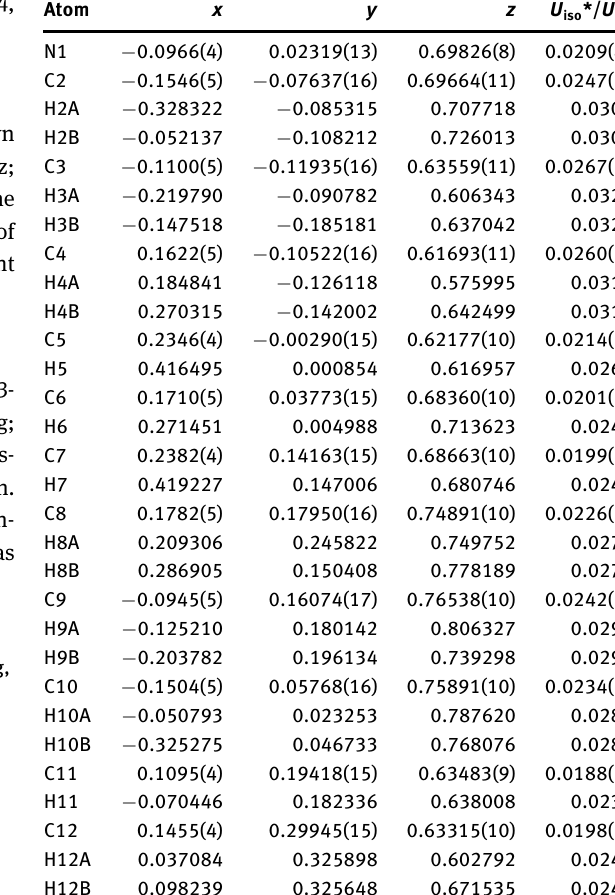
Table 2: Fractional atomic coordinates and isotropic or equivalent isotropic displacement parameters (Å 2